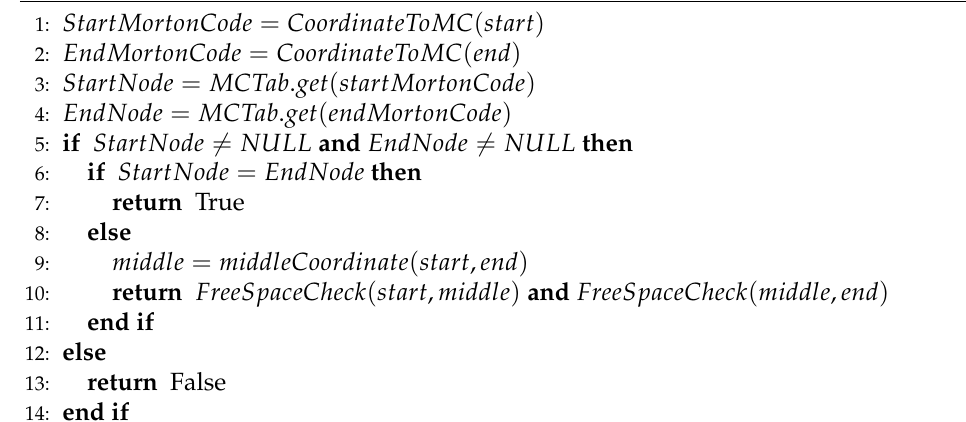
Algorithm 1 Free space checker: from the start position ( start ) and the end position ( end ), the two associated Morton codes are computed and then a dichotomy is performed to